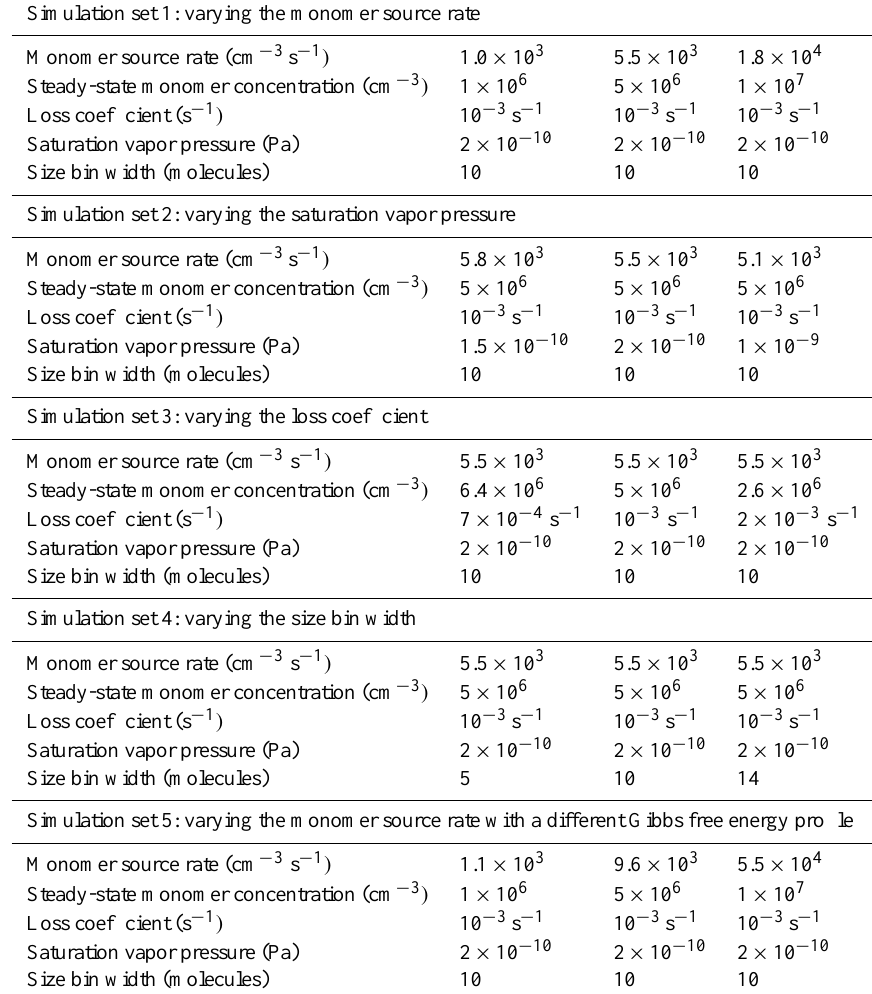
Table 1. Summary of the performed simulations. Simulation set 1: varying the monomer source